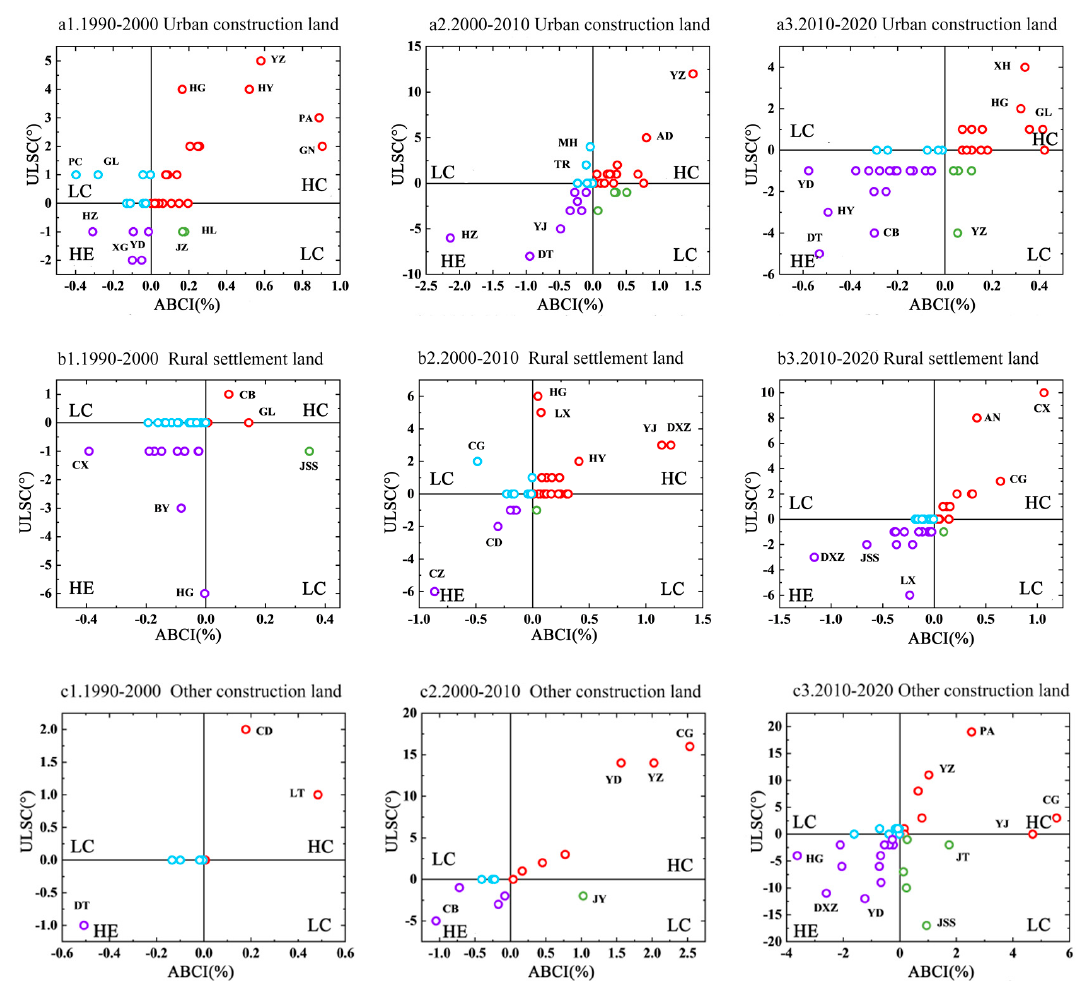
Figure 16. ABCI and ULSC results of counties (districts) in the LXUA from 1990 to 2020.